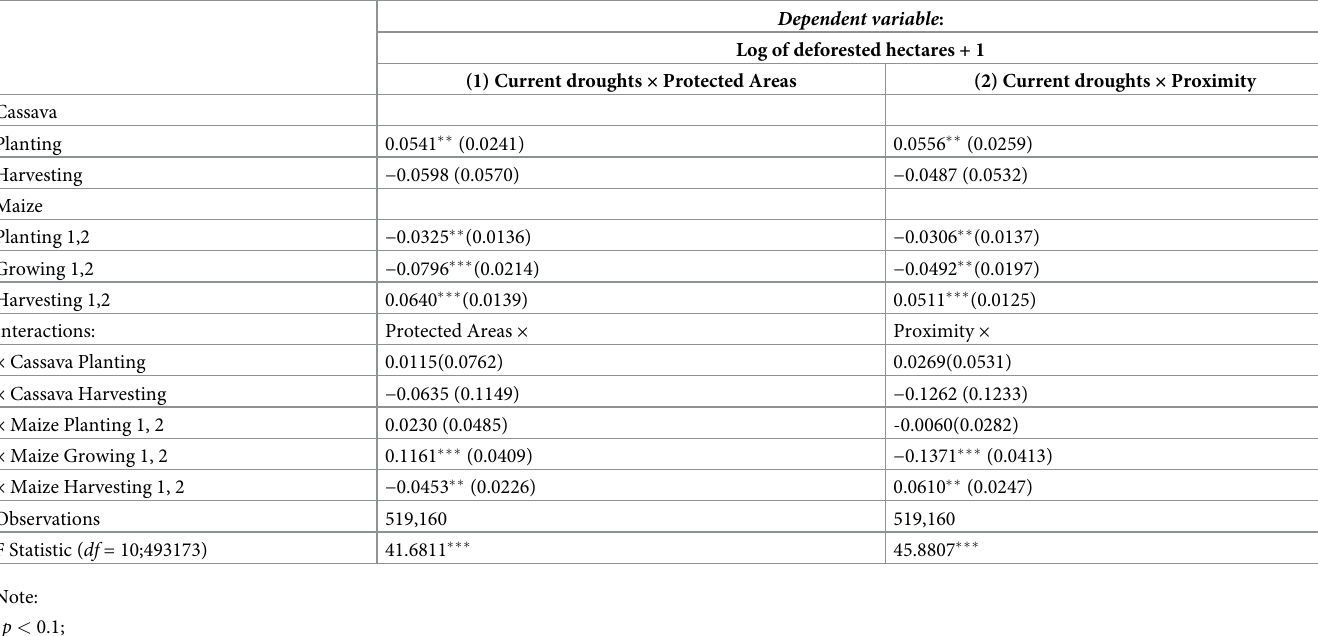
Table 2. Deforestation and current droughts; interaction with protected areas (installed before the year 2000) and proximity to main cities. The analysis considers cells characterized by least 50% forest cover in the year 2000. Total observations are then sampled to maintain only the 35% of the total.